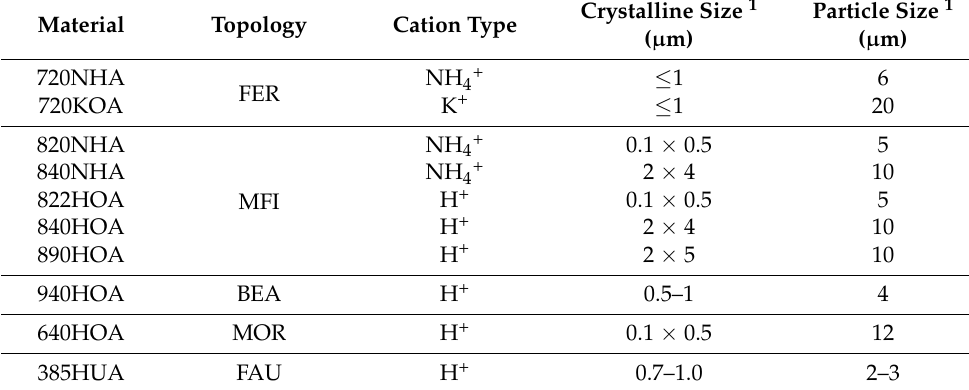
Table 7. Topology, cation type, crystalline size, and particle size of various